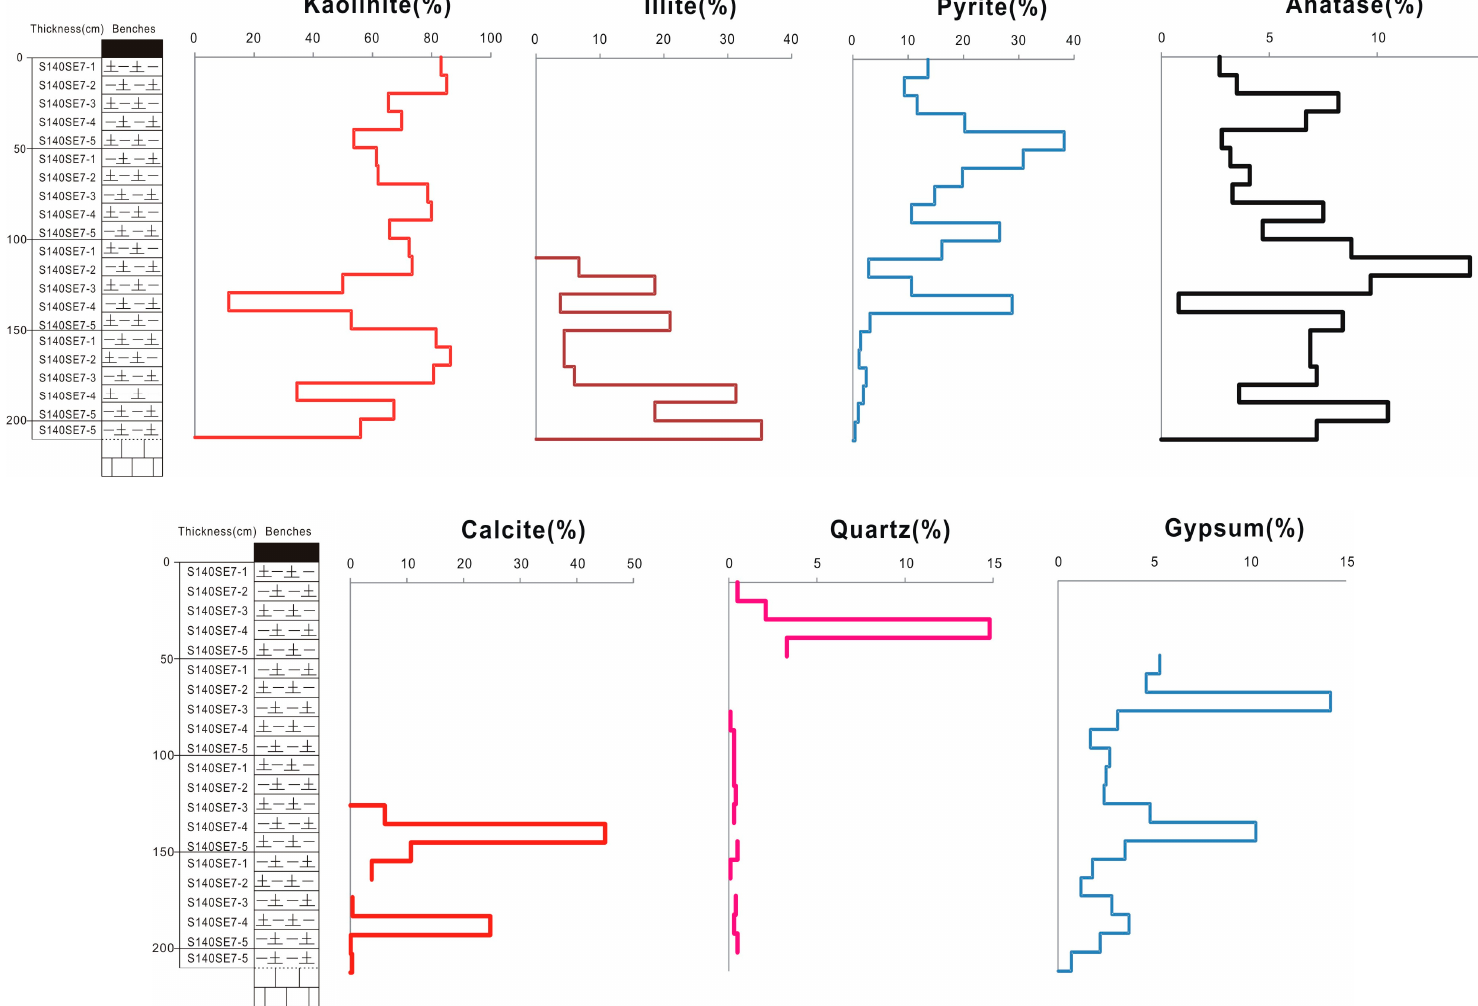
Figure 3. Vertical variations of minerals from the tuff in the Zhongliangshan mine.